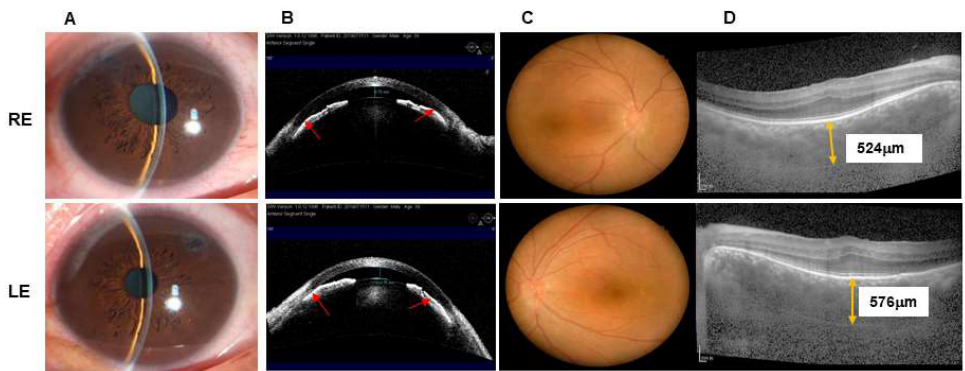
Figure 3. Preoperative images of 39-year-old man with nanophthalmos. ( A , B ) the preoperative anterior segment of both eyes showed a shallow anterior chamber (RE: 0.75 mm, LE: 0.76 mm) with angle closure (red arrow). ( C ) The fundus photographs of both eyes showed disappearance of macular fovea reflection. ( D ) Linear horizontal macular OCT scan revealed absence of a foveal depression, persistence of inner nuclear layers and thickened choroid. RE: right eye, LE: left eye. The patient subsequently underwent bilateral LPPV + ACSP + IOL + PC successively.